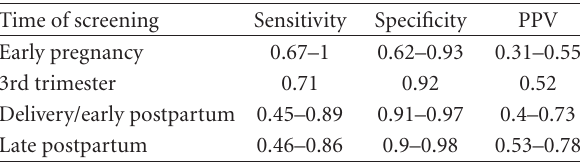
Table 2: TPOAb and its utility for screening for PPTD: timing of screening and sensitivity, specificity, and PPV (adopted from [25] with